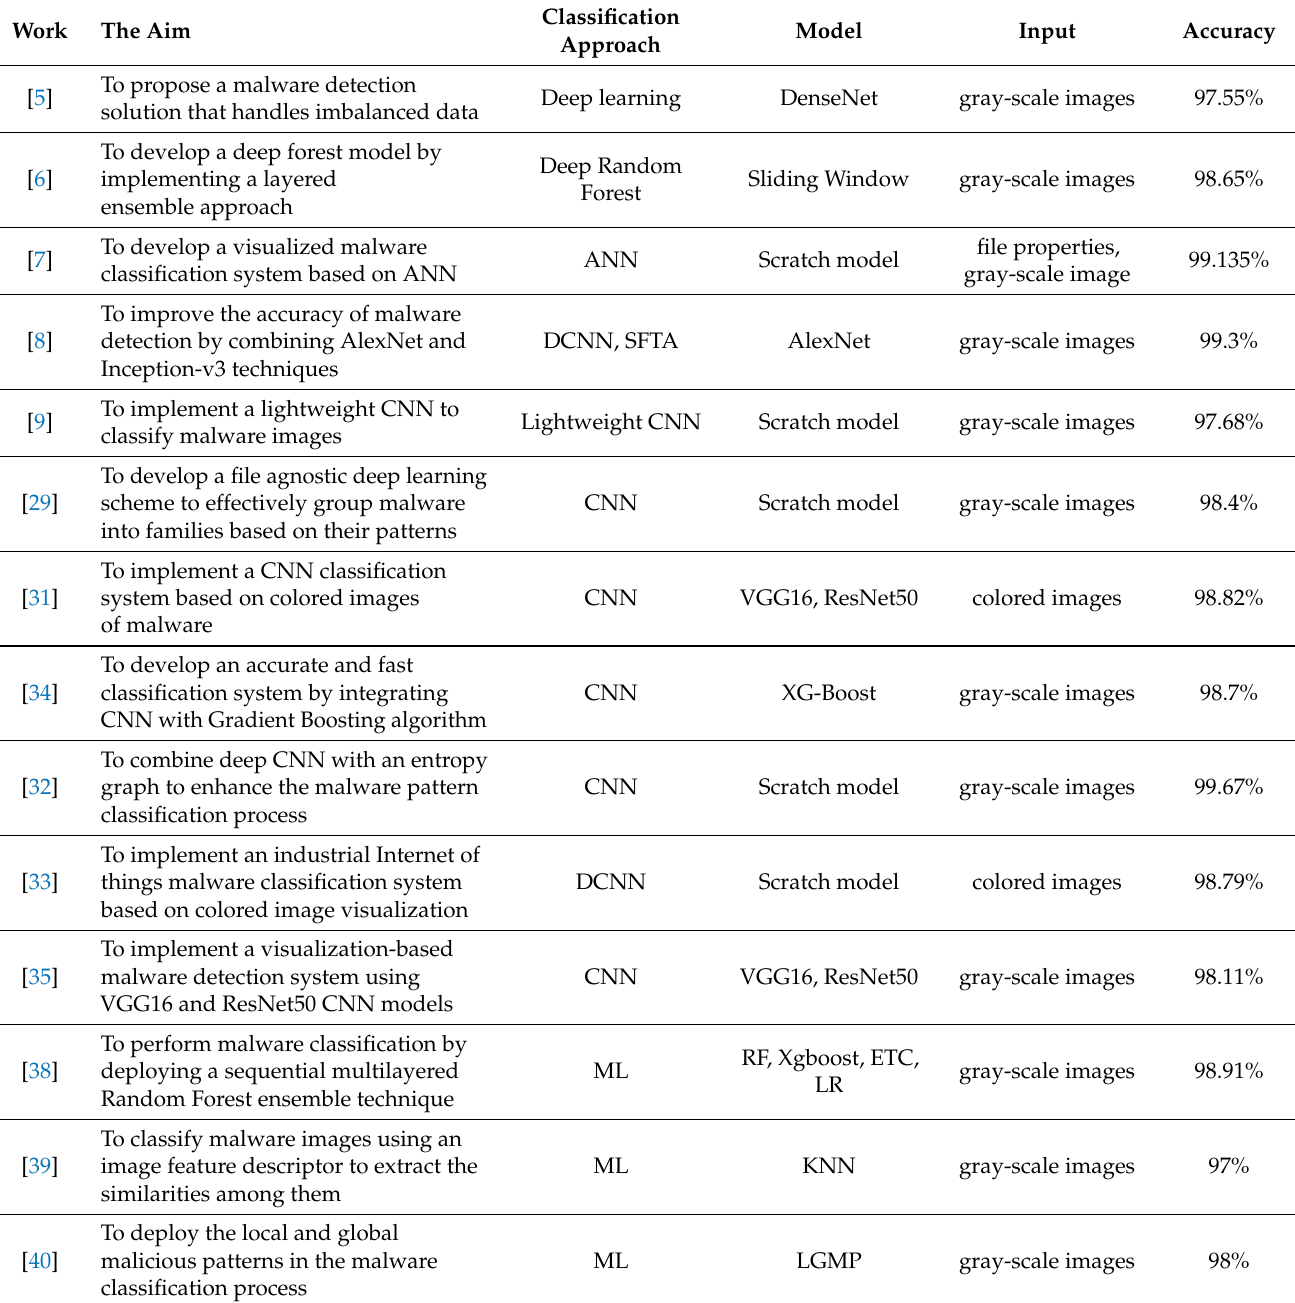
Table 1. Comparison among the recent related works that have employed Malimg in their